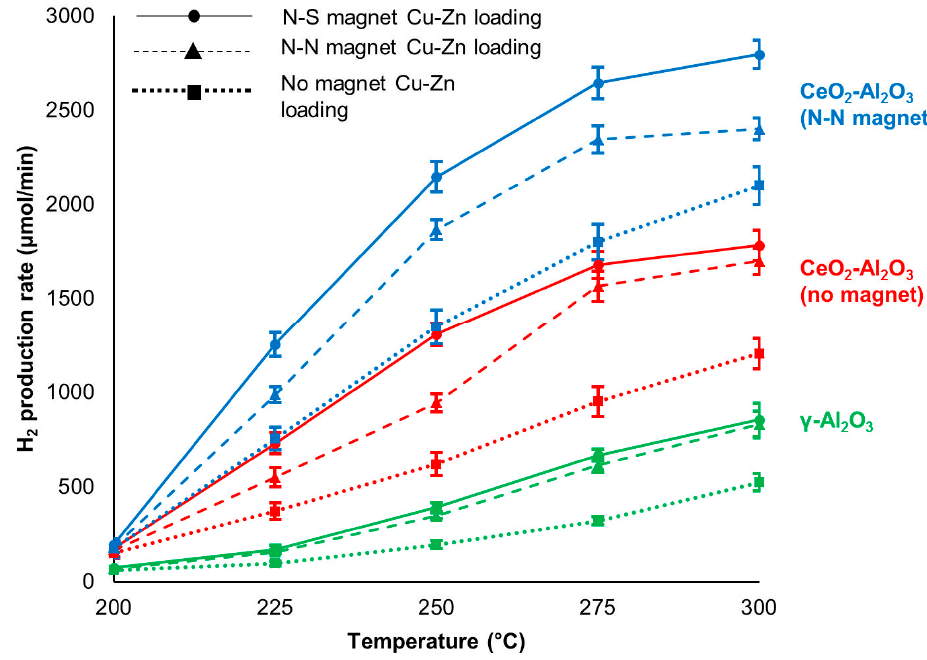
Figure 1. H 2 production rates of Cu-Zn catalysts on γ -Al 2 O 3 , CeO 2 -Al 2 O 3 (no magnet), and CeO 2 -Al 2 O 3 (N-N) supports.